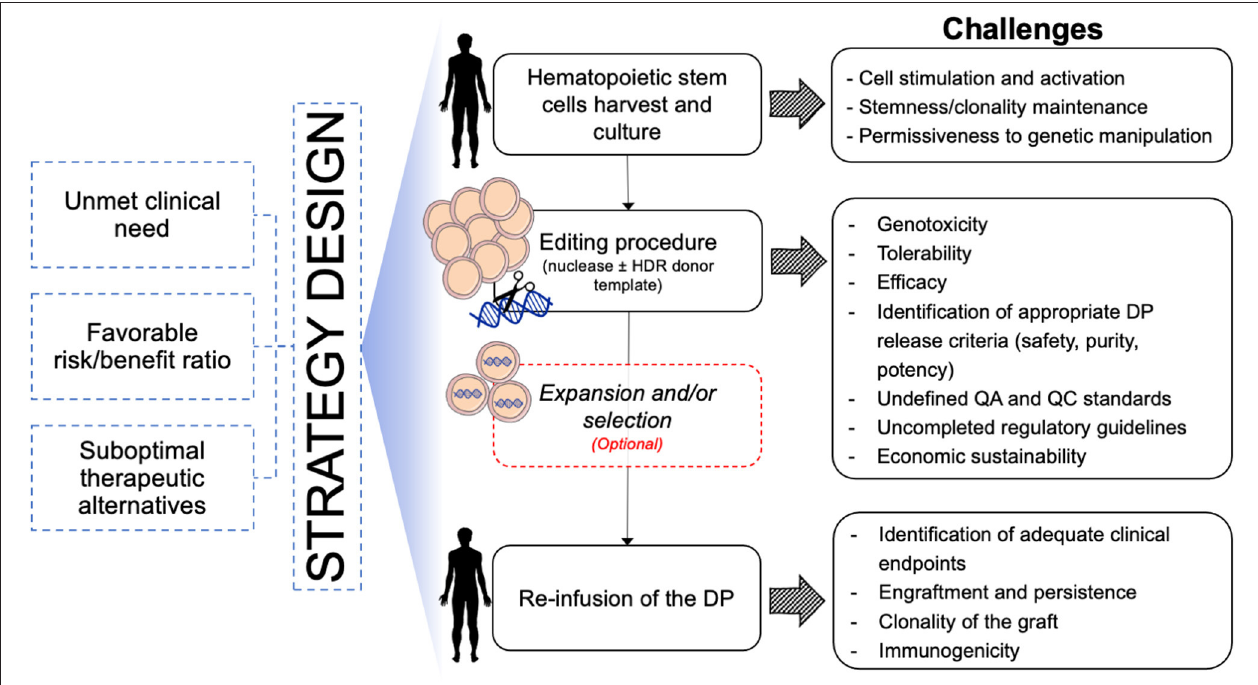
FIGURE 3 | Schematic of challenges toward clinical translation of HSPC gene editing for hematological diseases. DP, Drug Product; QA, Quality Assay; QC, Quality